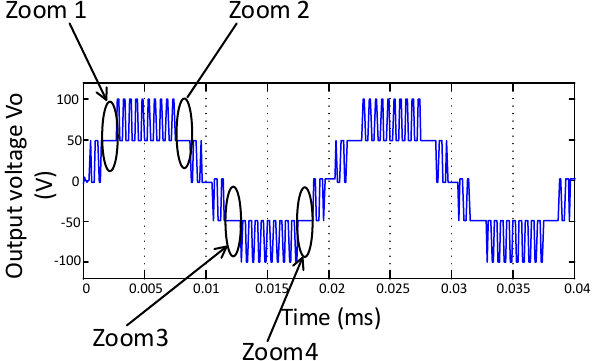
Figure 14. Output voltage of the converter with the proposed OPT-PWM control.